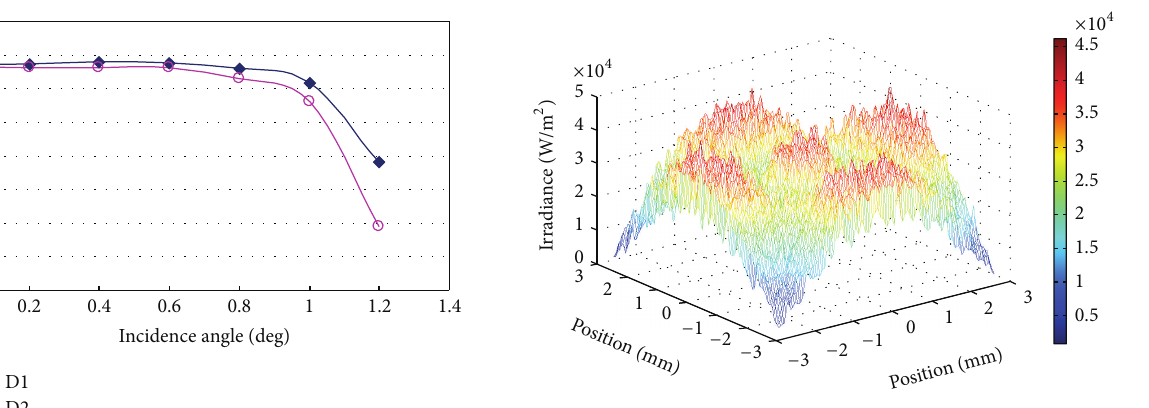
Figure 11: Optical efficiency with 2 optimal SOEs of Phase II under various incidence angles.